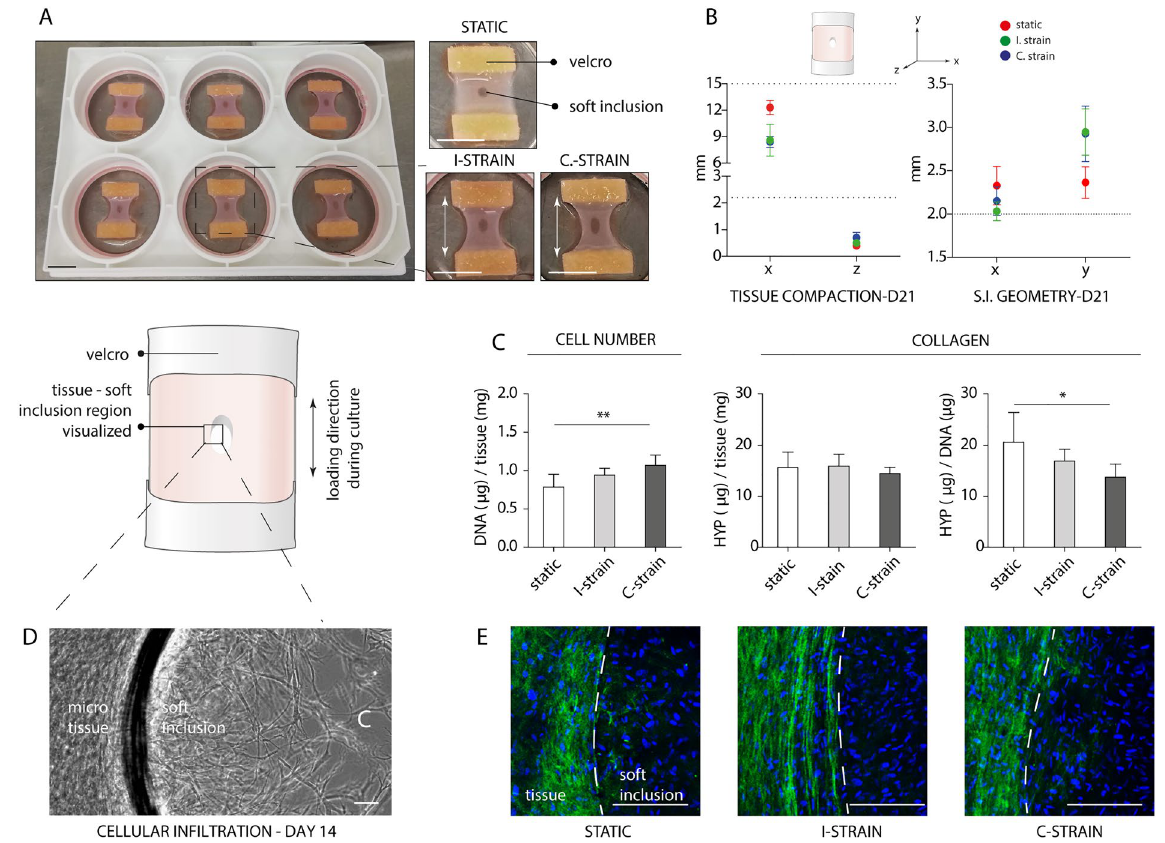
Figure 3. Comparison of three tissue-engineered fibrous cap models at day 21. Representative photographs underlining the reproducibility and rectangular/dog bone shape morphology of the created tissues at day 21. ( A ). Quantified tissue and soft inclusion (S.I.) geometry at day 21 in comparison to the initial sample and SI size (dotted lines), respectively (n ≥ 5 per group) ( B ). Cell number (DNA) and collagen (HYP) levels normalized to total tissue mass and cell content (n ≥ 5 per group) (*p < 0.05; **p < 0.01). ( C ) Representative bright field image of the tissue-soft inclusion interface before dynamic loading (day 14) demonstrating gradual cellular infiltration. The C indicates the center of the soft inclusion ( D ). Representative collagen (green) and nuclei (blue) stained zooms of the tissue-soft inclusion interface of each experimental group at day 21 displaying the differences in collagen presence between the artificial fibrous cap (i.e. tissue) and soft inclusion ( E ). Scale bars, 10 mm ( A ) and 100 µm ( D and E